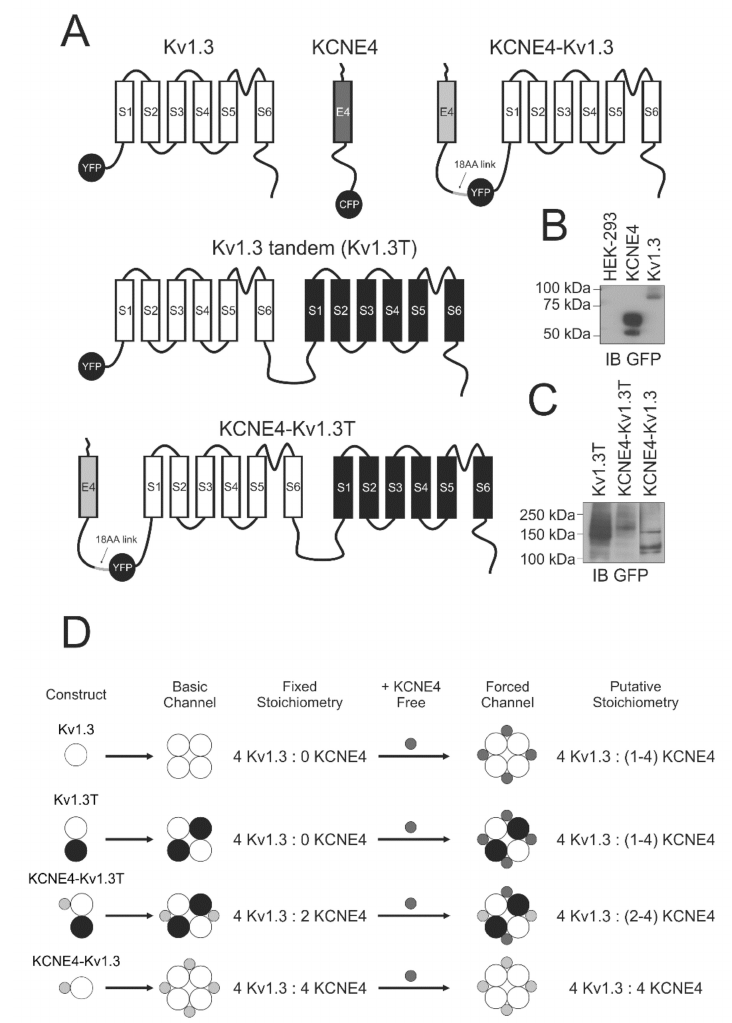
Figure 1. Chimeric constructs, protein expression and putative oligomeric formations. ( A ) Representative cartoon of the fusion proteins. All chimeras were tagged with either YFP or CFP. White and black barrels represent Kv1.3 peptides. Dark and light gray correspond to KCNE4 structures. In KCNE4-Kv1.3 and KCNE4-Kv1.3T, the 18 aa link is also indicated. ( B ) Western blot of the protein lysates of the nontransfected HEK-293 cells and HEK-293 cells transfected with KCNE4 and Kv1.3. ( C ) Protein levels of cells expressing Kv1.3T, KCNE4-Kv1.3T and KCNE4-Kv1.3. ( D ) Putative oligomerization of Kv1.3 and KCNE4 complexes according to the construct combination. Basic channels formed by chimeras exhibited fixed stoichiometries. The addition of free KCNE4 units yielded forced channels with putative stoichiometries. 1–4, the number of KCNE units by complex, which varied from 1 to 4. 2–4, the number of KCNE units by complex, which varied from 2 to 4. White and black circles represent Kv1.3 peptides. Light gray corresponds to KCNE4 chimeras linked to Kv1.3. Dark gray highlights excess KCNE4